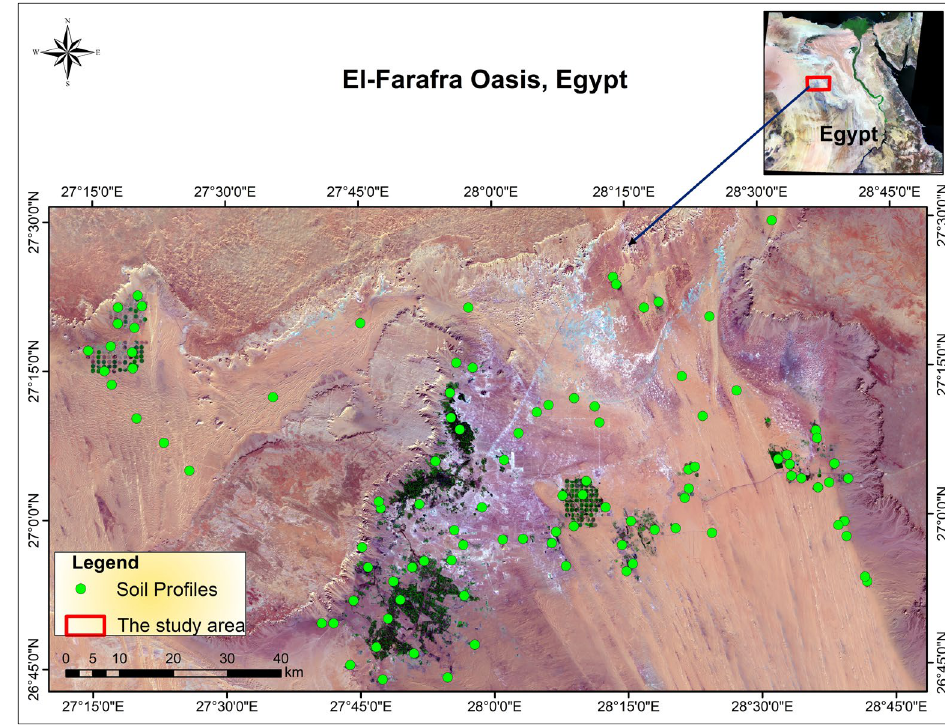
Figure 1. Soil profile location map in El-Farafra Oasis, (Landsat-8 (OLI) satellite image).